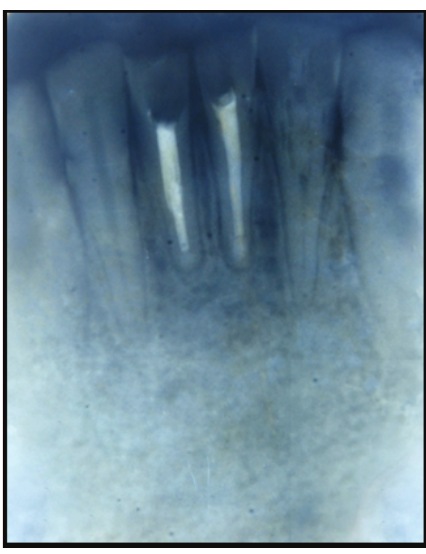
Figure 4: Postoperative radiograph after one year showing